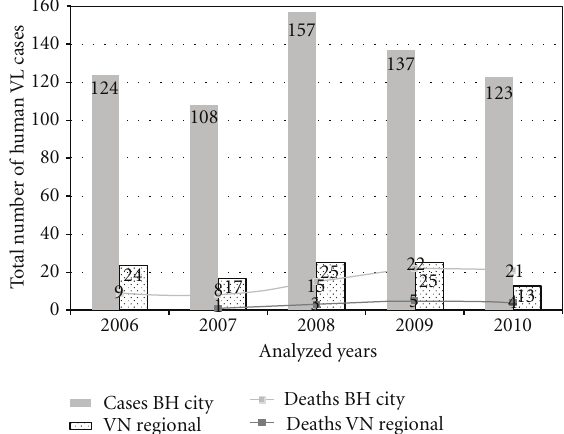
Figure 8: Cases and deaths of Visceral Leishmaniases in Belo Horizonte City and in the Venda Nova Sanitary District from 2006 to